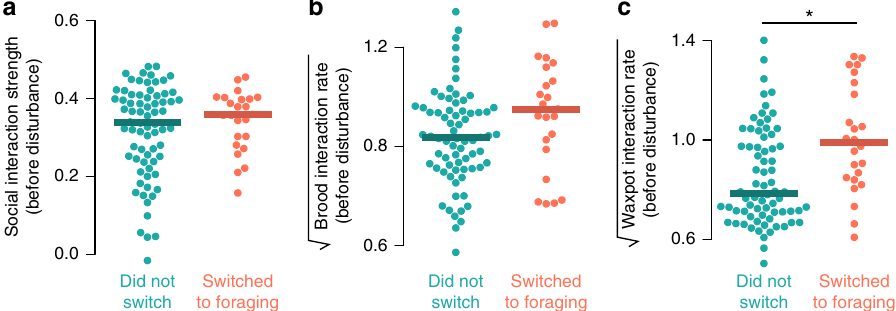
Fig. 7 Interaction with food storage pots predicts foraging initiation after disturbance. Beeswarm plots of nest behavior metrics before experimental disturbance by foraging status after disturbance, among bees that had performed no foraging before disturbance. a Social interaction strength (estimated by mean spatial correlation strength to nestmates, see above). b Rate of interaction with brood, and c rate of interaction with waxpots where food may be stored. Points show values for individual bees, and thick lines show median values for group. * p < 0.05 in a generalized linear mixed-effects